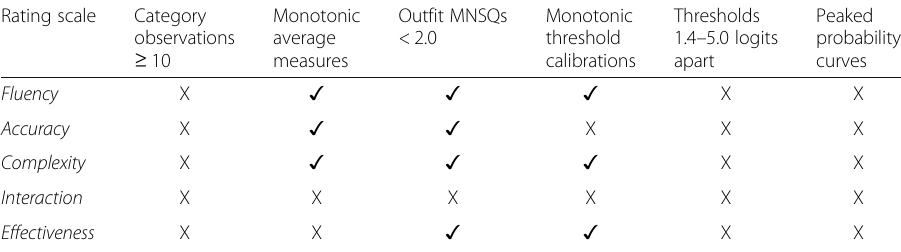
Table 3 Summary of adherence to Linacre ’ s (2002a) guidelines for the 9-point rating